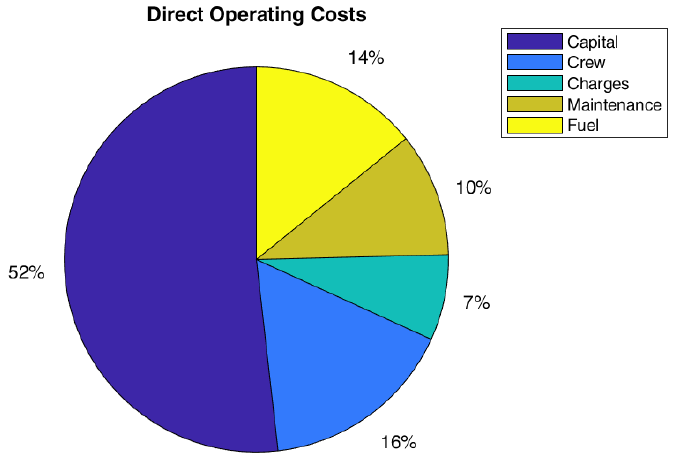
spect to Ref. configuration (see [1]) and the new reference, herein, named Conf. A (configuration Figure 5. Pie chart of DOC for Configuration A (SM = 1.75, with SHM). with SHM, but with SM = 2).